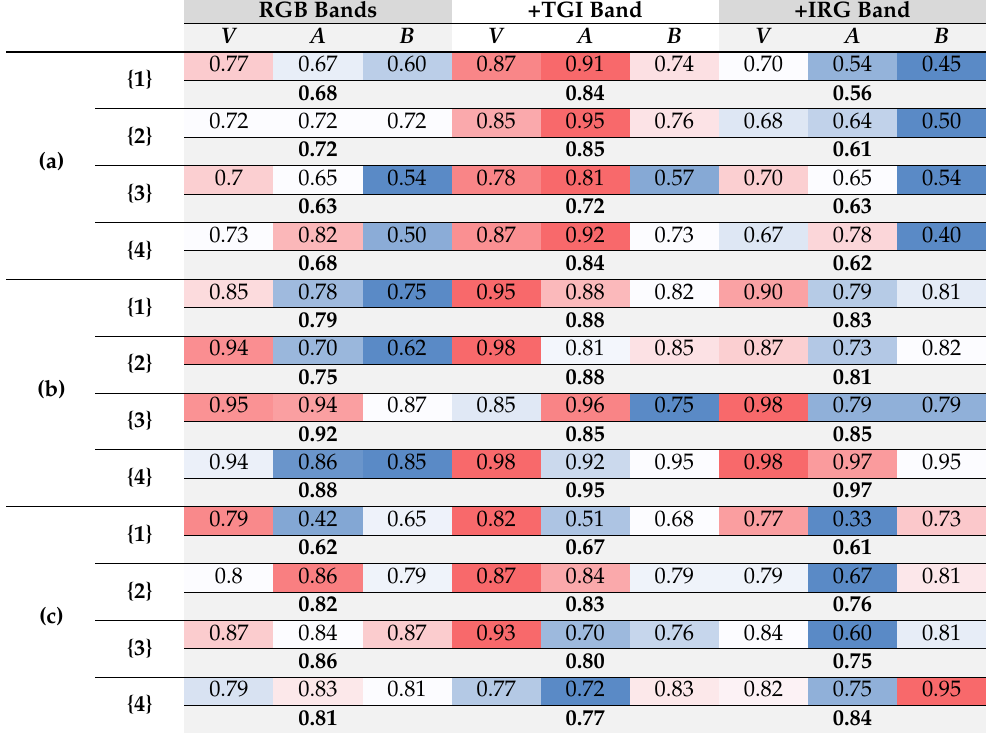
Table 5. Summary of the F-score values calculated for the cases under study, at various spatial resolutions and for each class: V identifies vegetation, A stands for asphalt while B represents bare soil. Colours tending towards blue identify low F-score values for each resolution in the three classification modes, conversely, colours tending towards red identify high F-score values. In bold are the average values of the F-scores per case study and classification